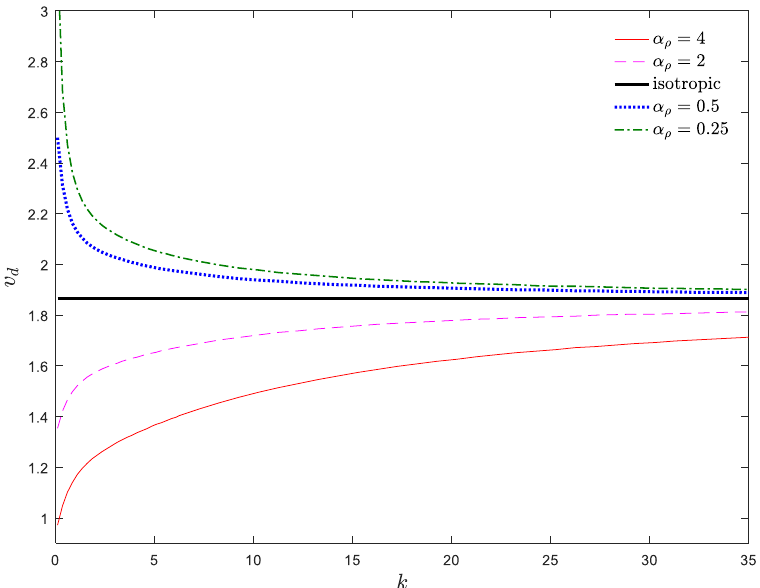
Figure 11. Dimensionless divergence velocity of a nanobeam against power index for ζ = 0, α E = 1, µ = 0, k = 0, k f = 0.5.